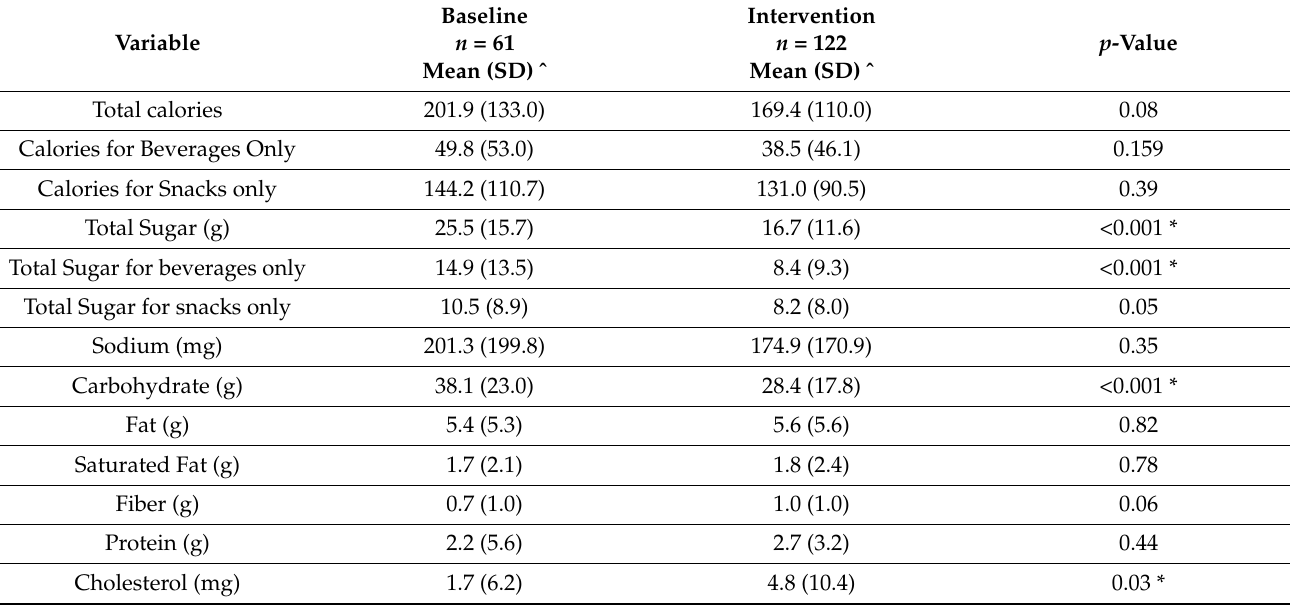
Table 2. Comparisons between nutritional outcomes per game between baseline intervention to postintervention